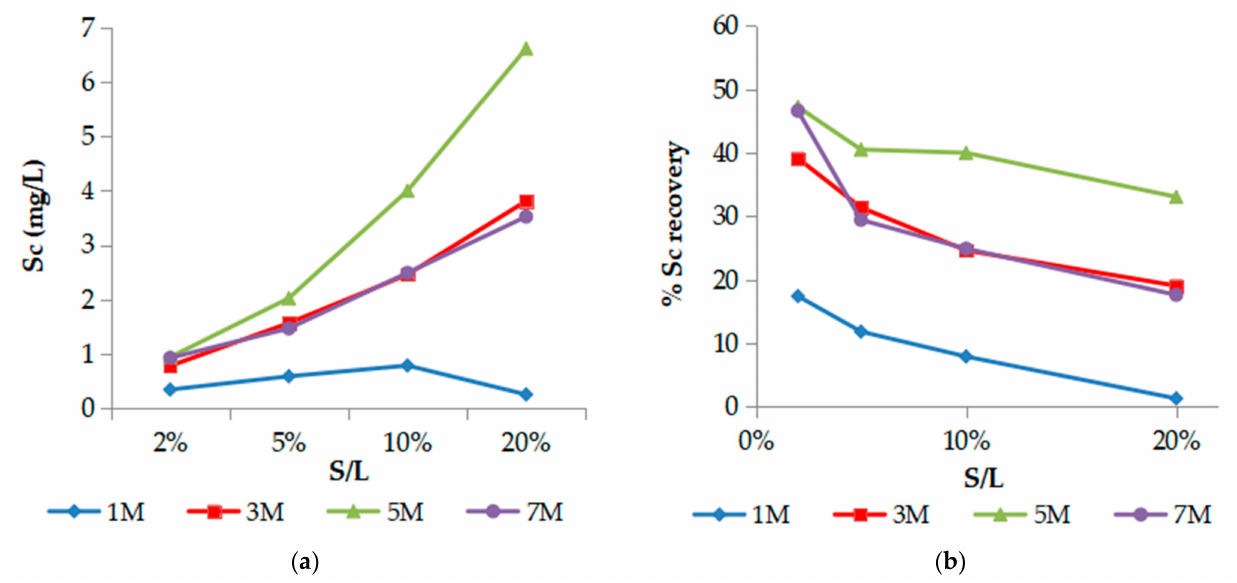
Figure 2. Effect of S/L ratio (pulp density) on Sc concentration ( a ) and % Sc recovery ( b ). (T = 25 ◦ C, t = 60